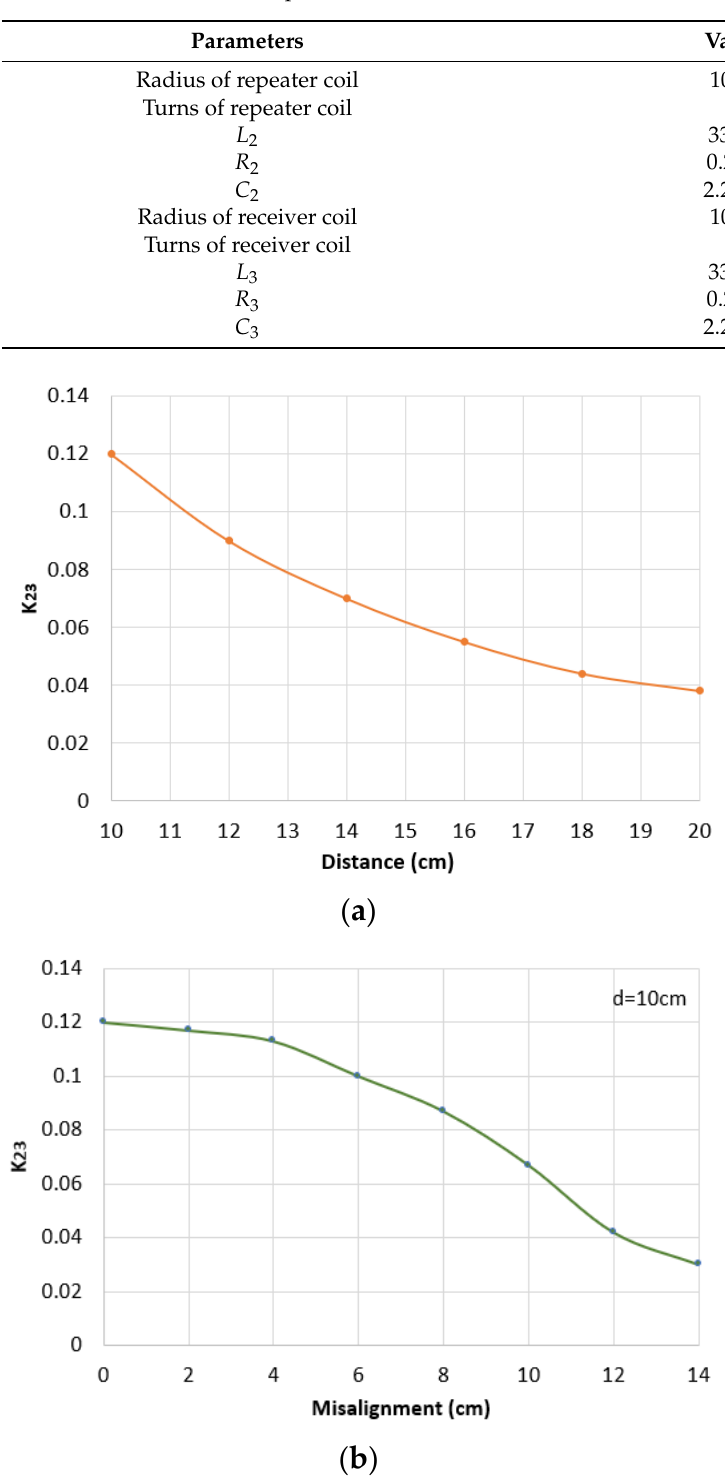
Figure 8. ( a ) k 23 versus transmission distance; ( b ) k 23 versus misalignment when distance is 10 Figure 8. ( a ) 𝑘 versus transmission distance; ( b ) 𝑘 (cid:2870)(cid:2871) cm.